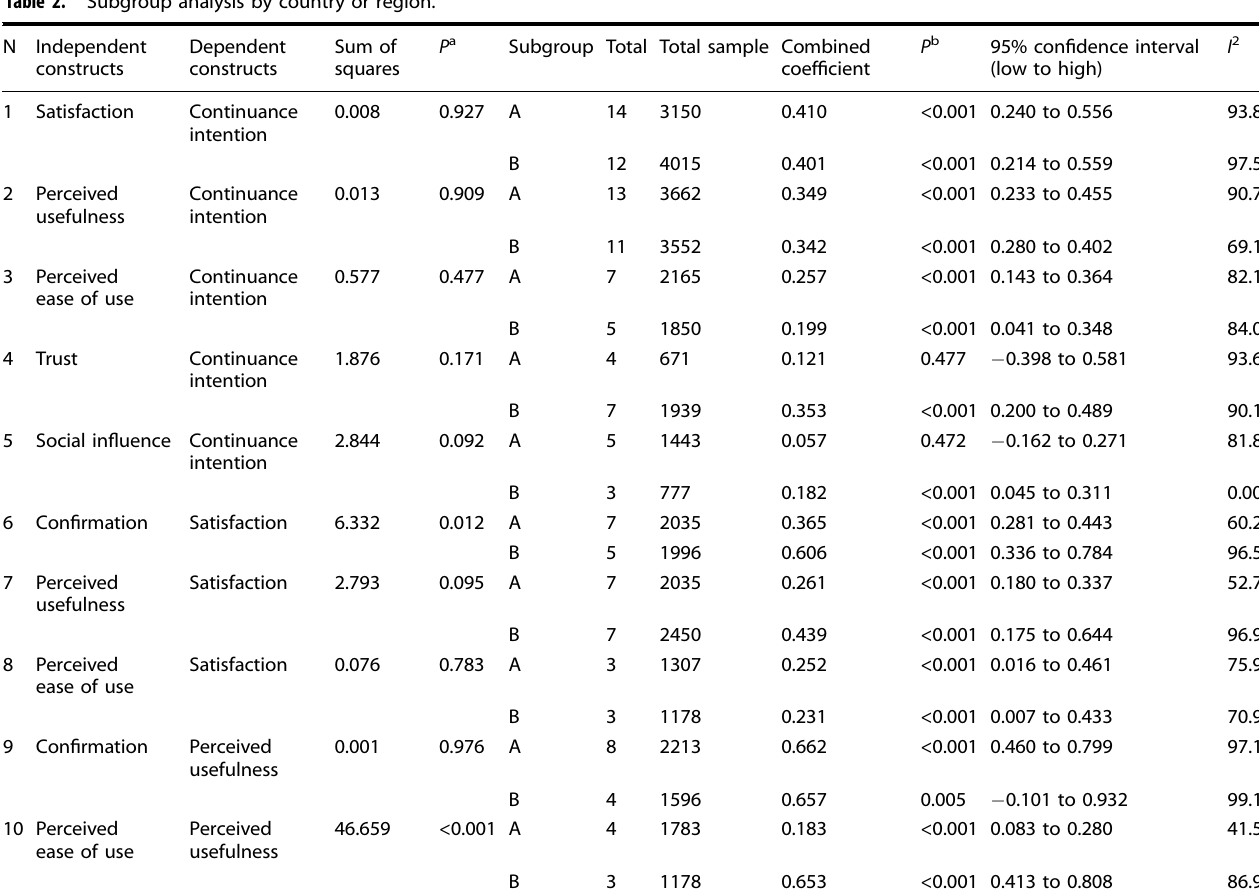
Table 2. Subgroup analysis by country or